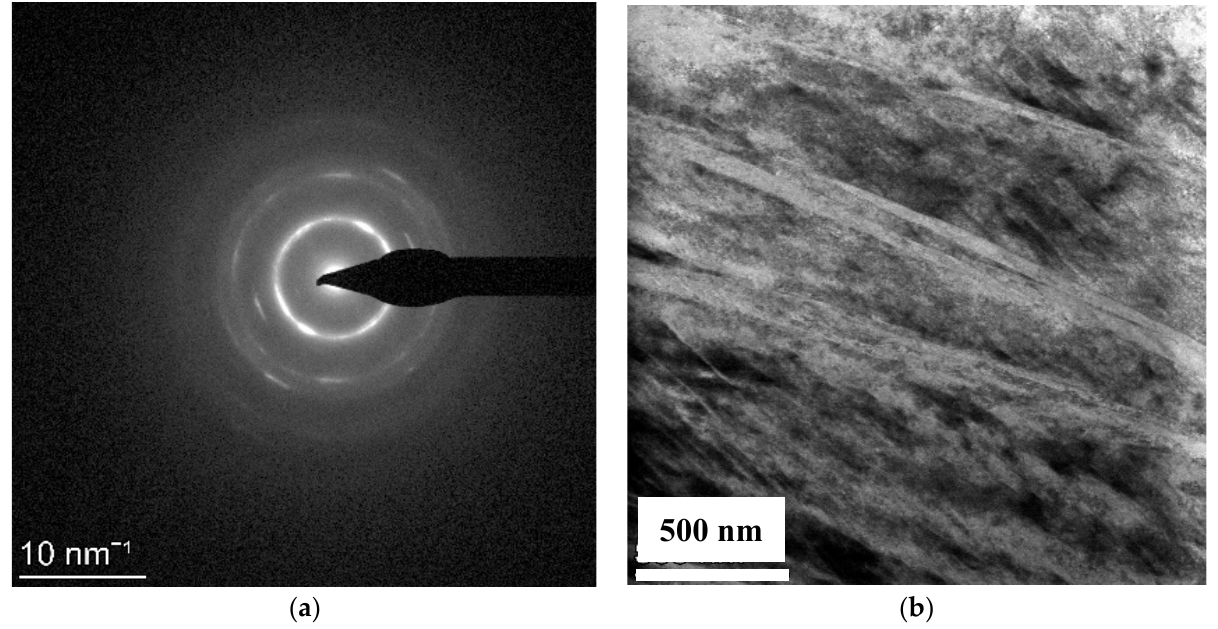
Figure 6. ( a ) Selected area diffraction pattern of the as-received Nitinol with a continuous center ring. The rings surrounding the center ring were less continuous. ( b ) Bright field TEM micrograph of the as-received Nitinol showing a lamellar structure with high plastic deformation. The lamellar structure was not very clear on account of the high plastic deformation.